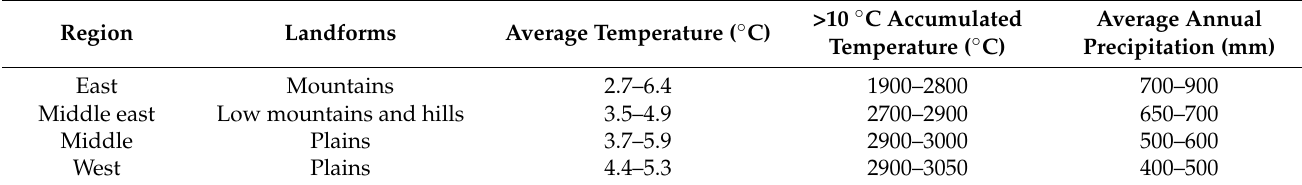
Table 1. General characteristics of different regions in Jilin Province.